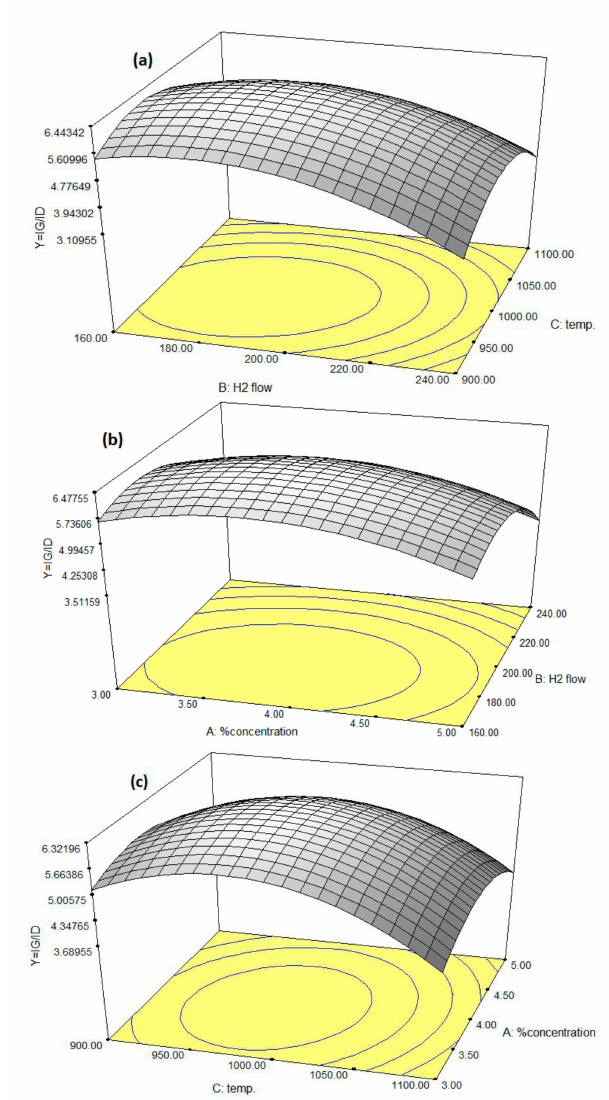
Figure 7. Three-dimensional surface graph to investigate the effect of ( a ) hydrogen flow rate (cm 3 /min) and reaction temperature ( ◦ C); ( b ) catalyst concentration (wt %) and hydrogen flow rate; ( c ) catalyst concentration (wt %) and reaction temperature ( ◦